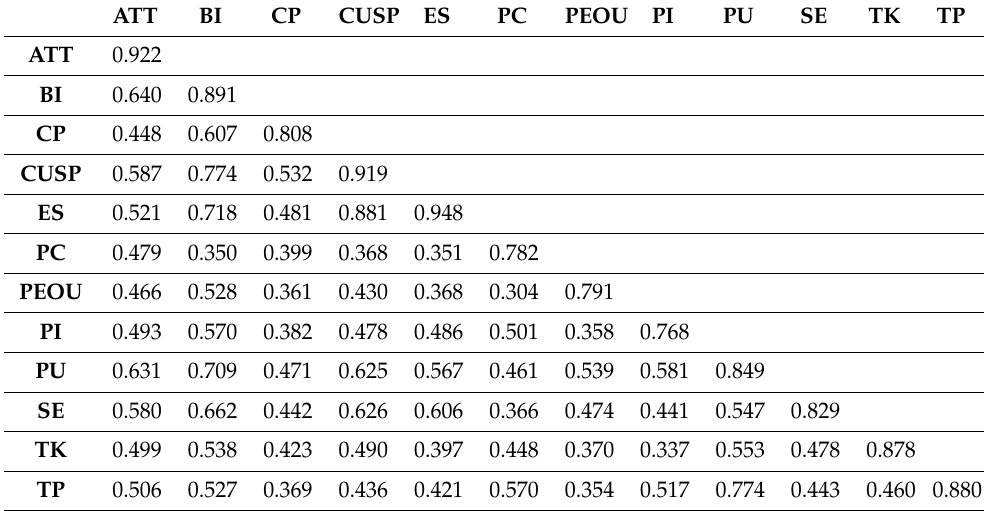
Table 2. Fornell–Larcker correlation matrix.